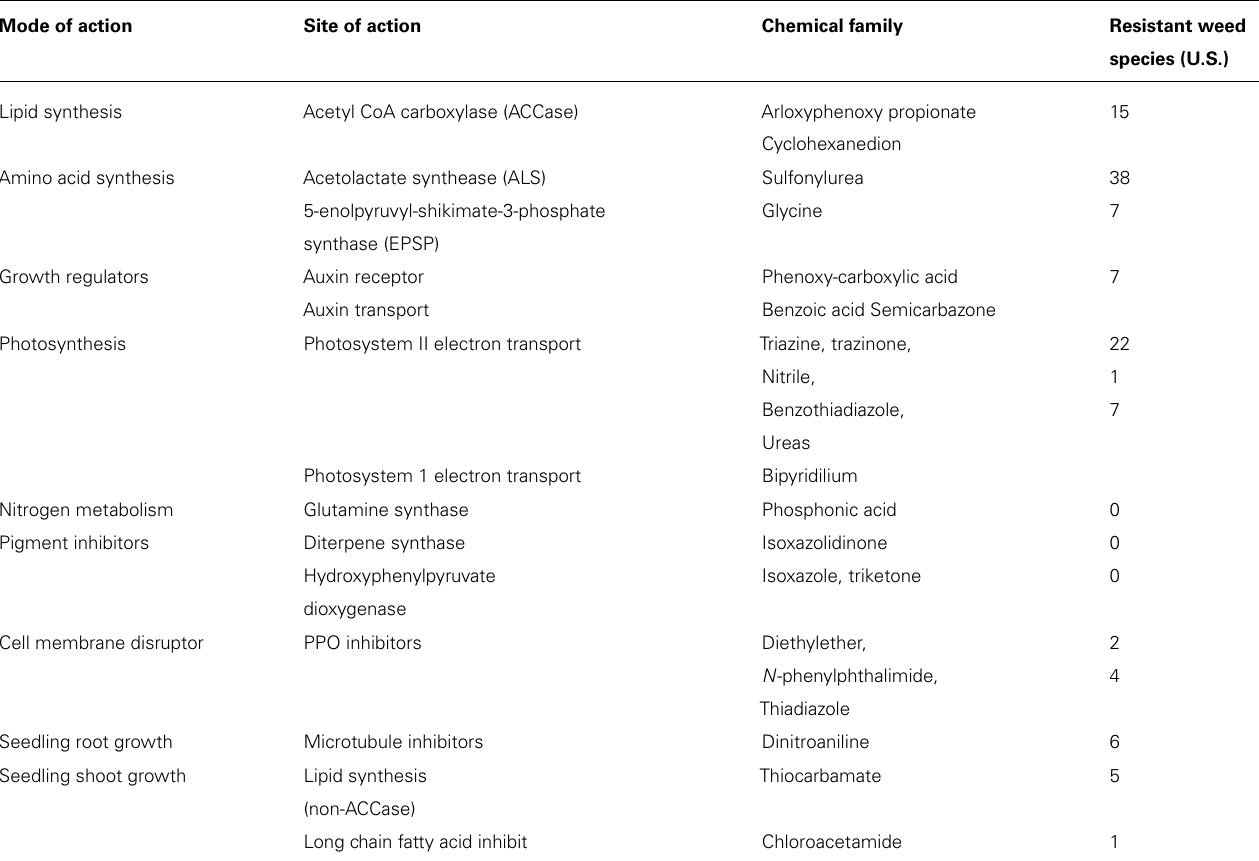
Table 1 | Herbicide mode-of-action and chemical